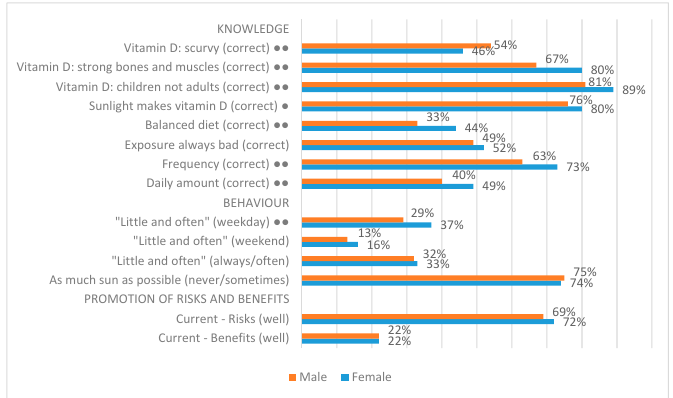
Figure 7. Gender differences in survey responses. A single dot indicates a significant difference in Figure 7. Gender di ff erences in survey responses. A single dot indicates a significant di ff erence in response at 0.05 (95%) and two dots signify a significant difference at 0.0005 (99.95%). response at 0.05 (95%) and two dots signify a significant di ff erence at 0.0005